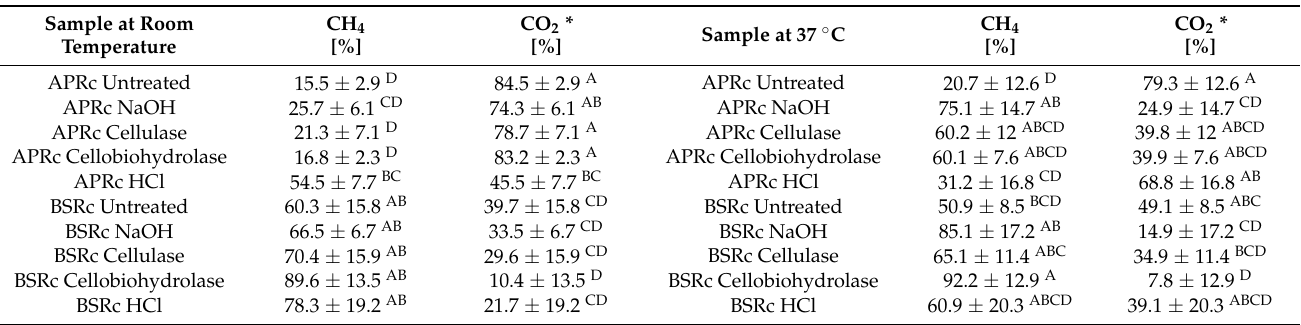
Table 4. Methane content of substrates with and without pretreatment at room temperature and at 37 ◦